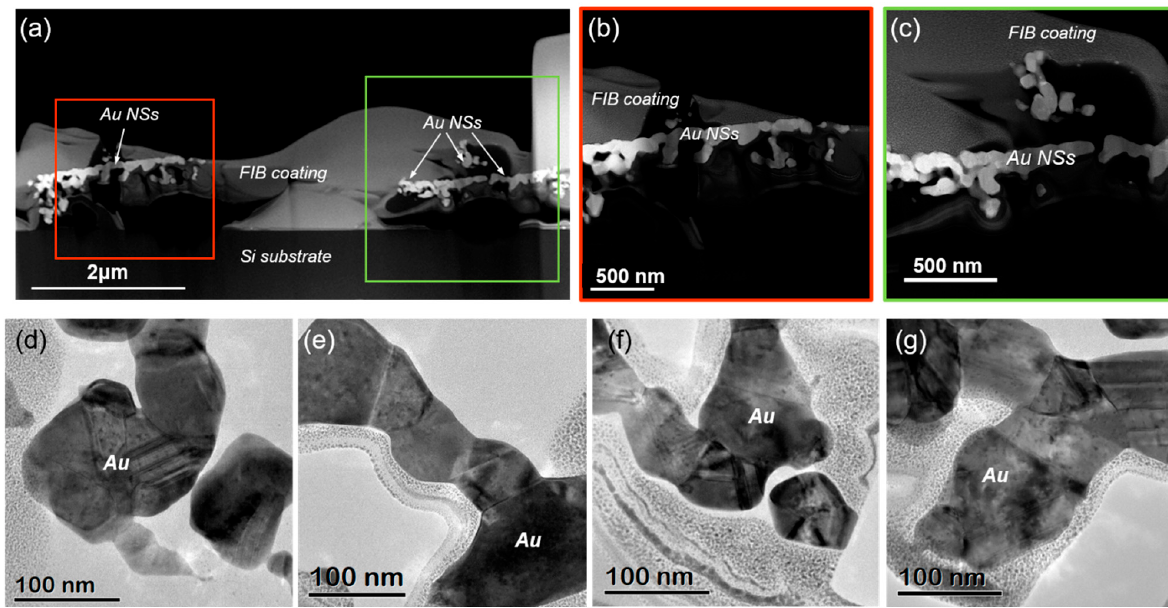
Figure 10. ( a – c ) STEM after FIB cut and ( d – g ) TEM images of the cross-section of different AuNSs made with an LP = 100 mW and ET = 150 ms and the second immersion in a 10 − 2 M HAuCl 4 solution for 30 min. After the bath (see Figure 5d), individual AuNPs are not appreciated. High magnification TEM images of the AuNPs in ( d – g ) show that they have been merged by their facets and exhibit a higher polycrystalline morphology.